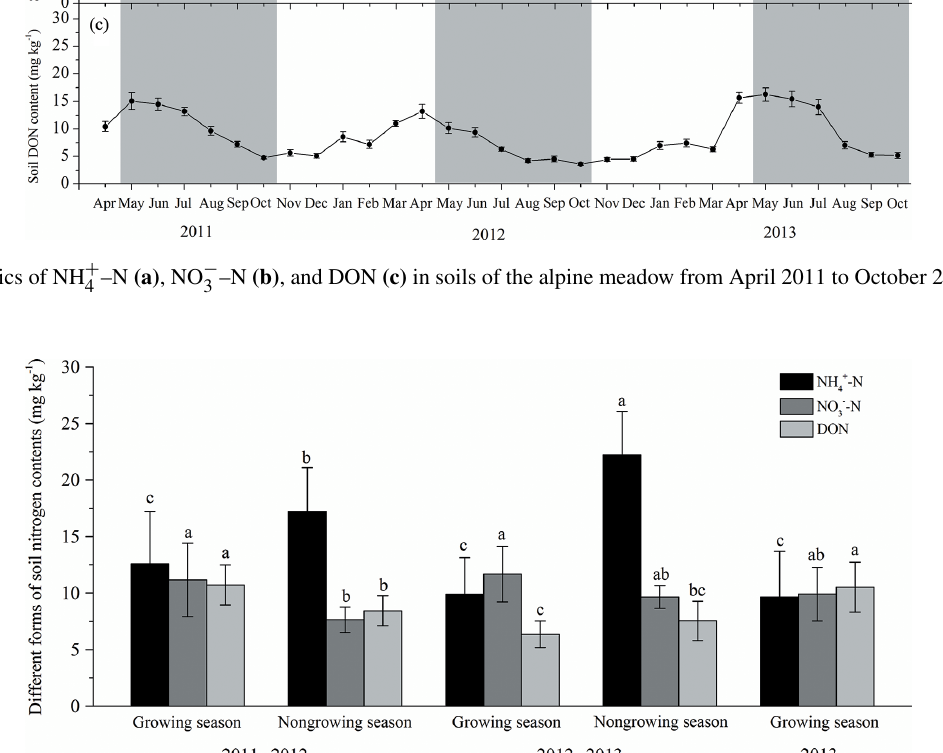
Figure 8. Changes in NH + –N, NO − –N, and DON of growing and nongrowing seasons from 2011 to 2013 (mean ± SE; n = 90). The 4 3 sampling time was on the 15th day of each month from May to October during the growing season and during the nongrowing season from November to April of the following year. Seasonal and interannual differences were compared using two-way ANOVA. Different lowercase letters indicate significant differences of the interaction effects between season and year determined via Duncan’s test ( p < 0.05).